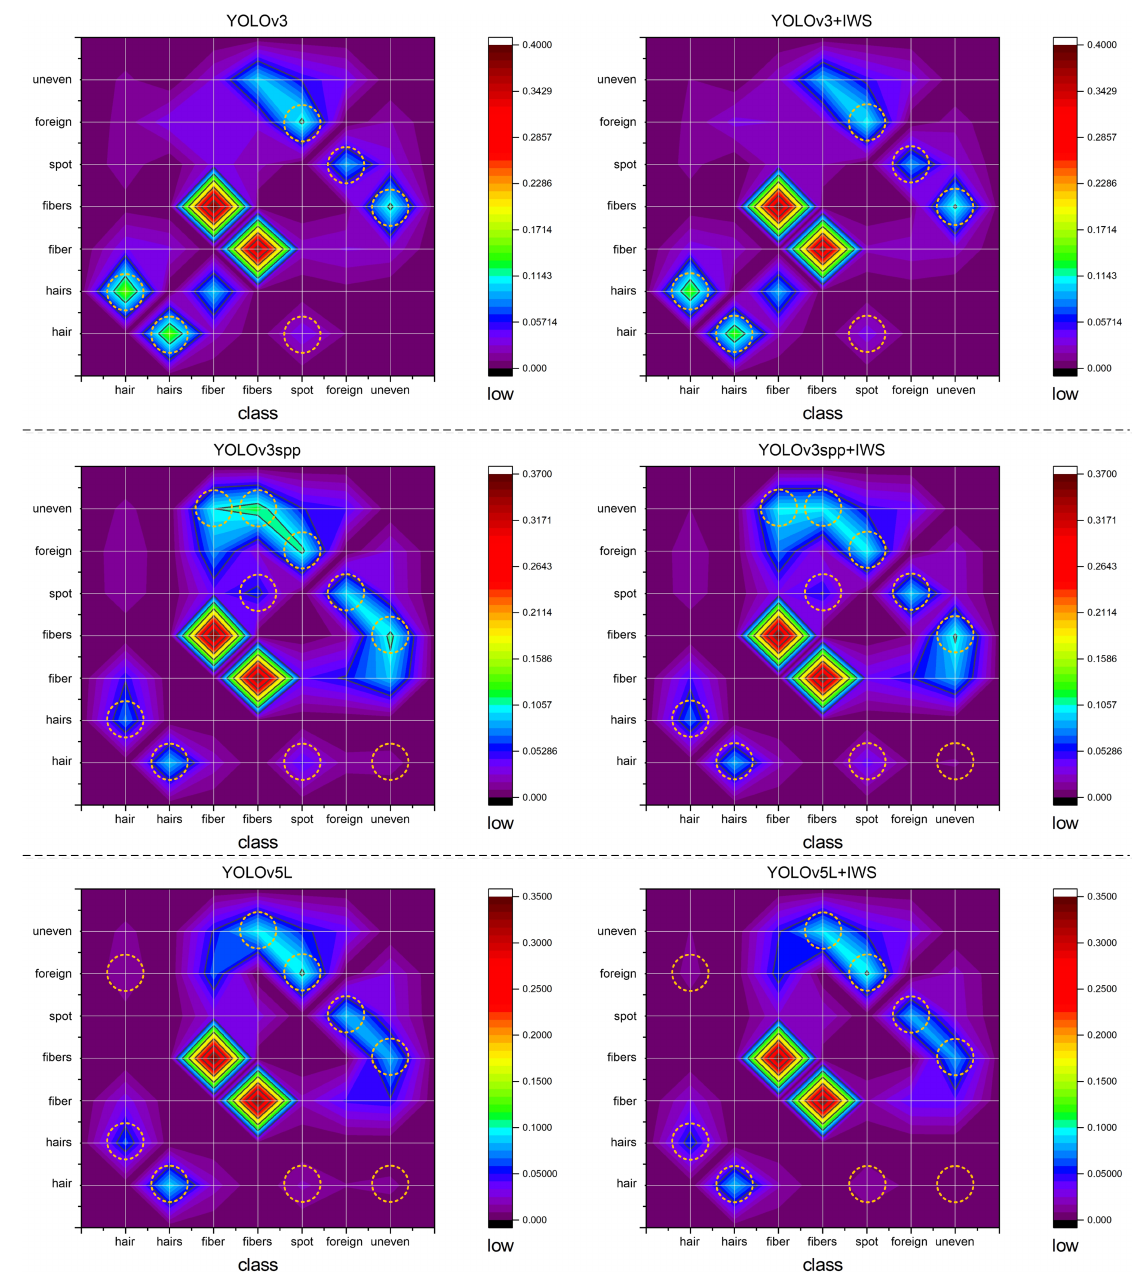
Figure 12. Visualization of the false detection rate of different classes as the same class.